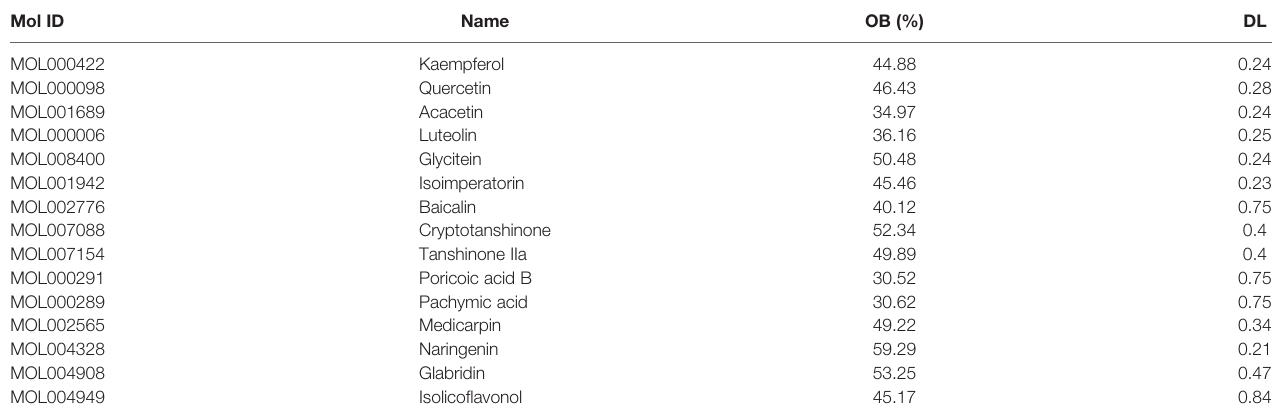
TABLE 1 | Active components of TSWN formula.